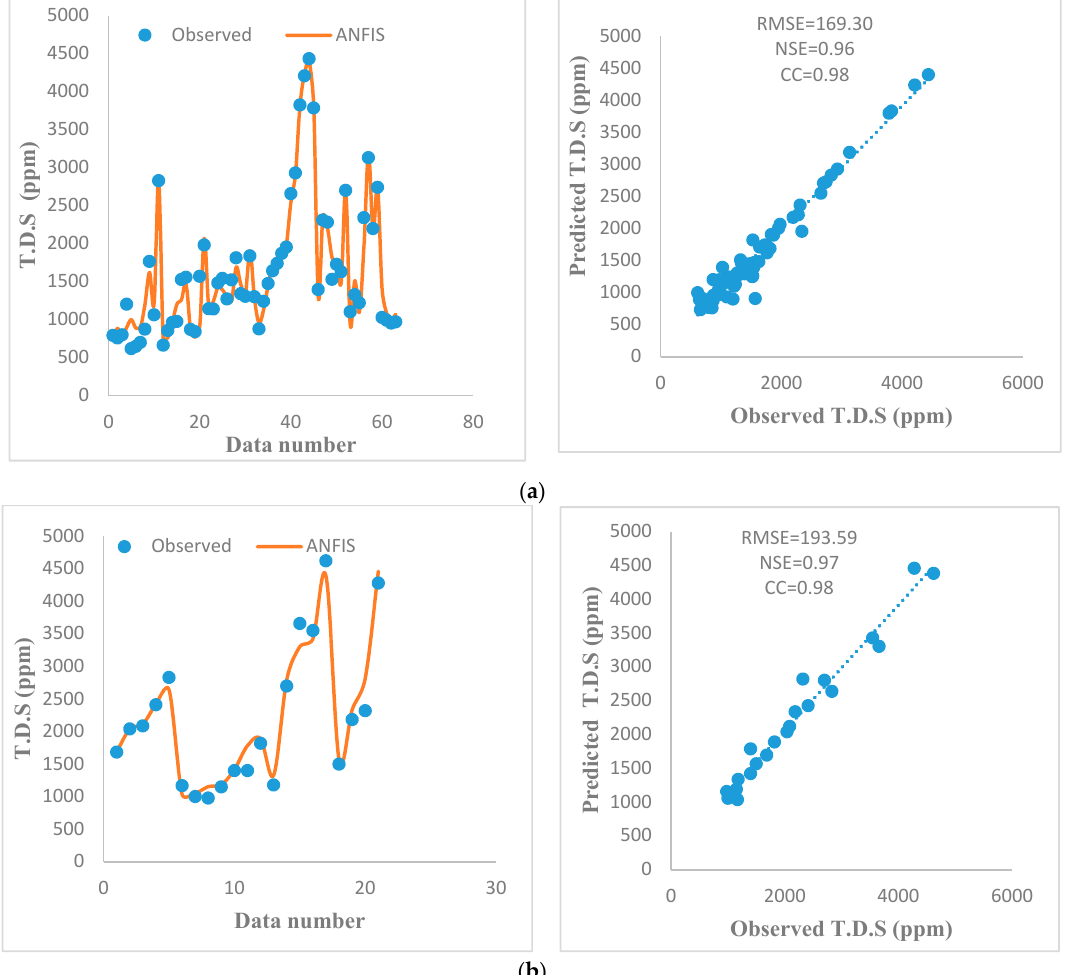
Figure 5. Comparative plots of observed and predicted TDS values using ANFIS model for ( a ) calibration data set and ( b ) validation.